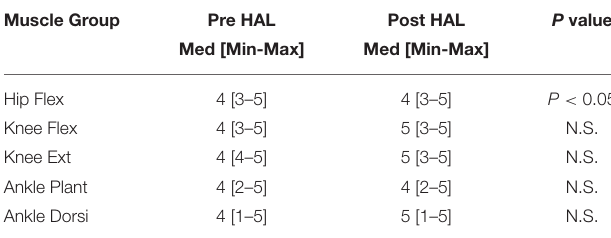
TABLE 5 | Comparison of MMT scores between pre and post HAL intervention in chronic stage patients. Muscle Group